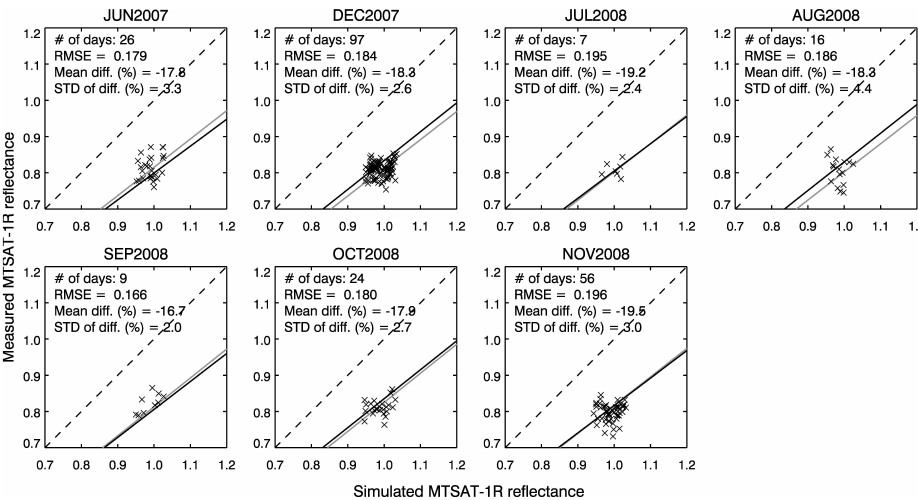
Fig. 14. Same as in Fig. 10 but for the MTSAT-1R 0.724-µm channel.